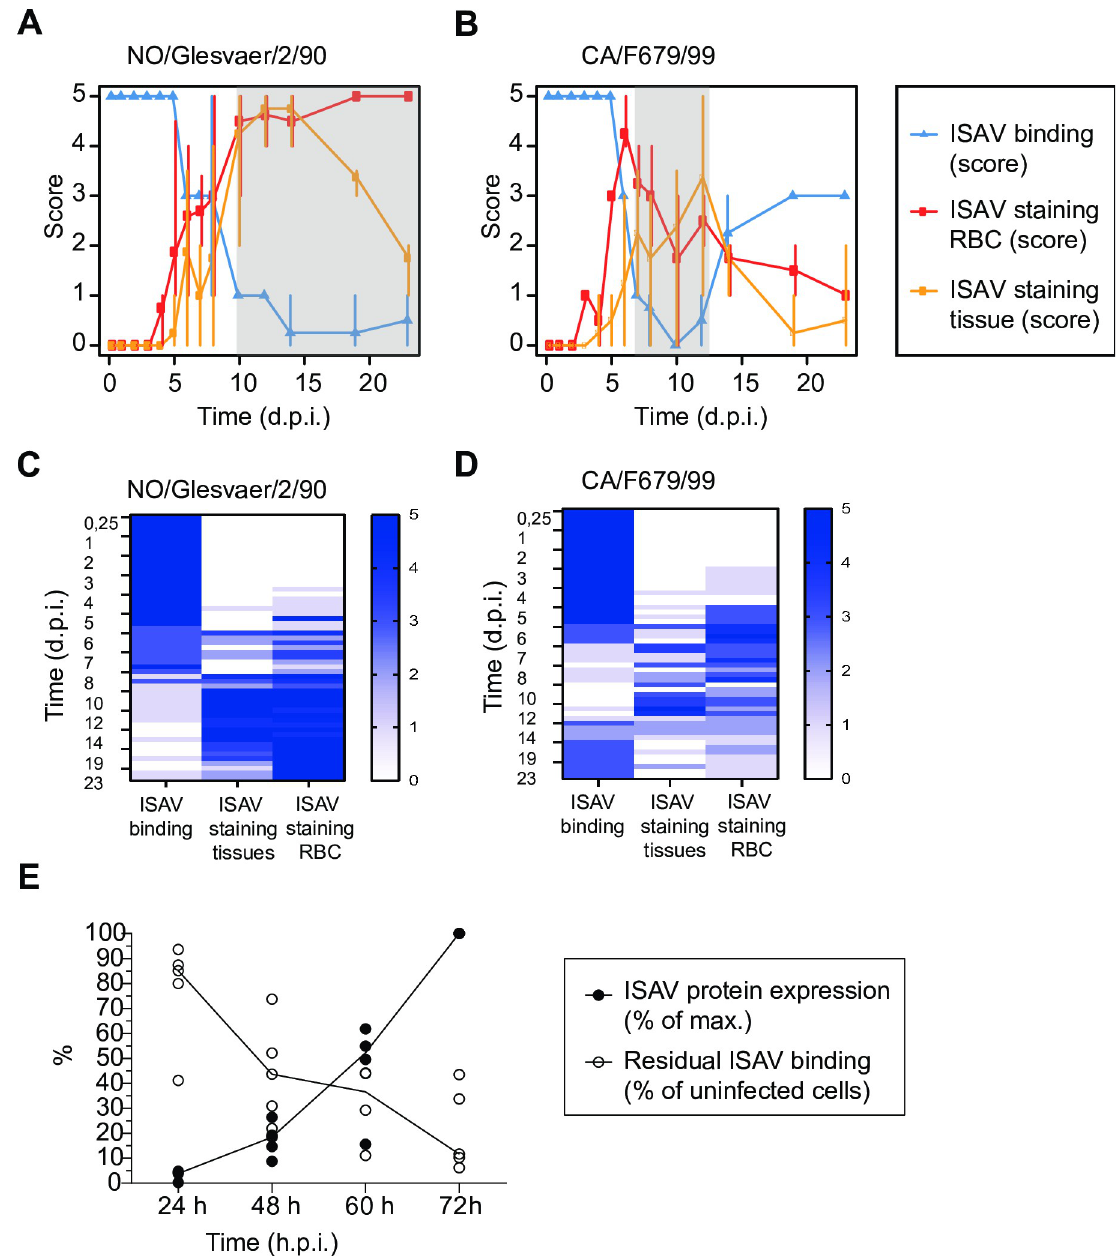
Fig 4. The loss of the cellular ISAV receptor correlates to circulating virus levels and cellular production of viral proteins. (A-D) Semi-quantitative scoring of virus histochemistry (ISAV binding, blue), immunohistochemical detection of ISAV NP in heart sections (ISAV staining tissue, yellow), and immunofluorescent staining of ISAV HE in blood smears (ISAV staining RBC, red) in fish infected with NO/Glesvaer/2/90 and CA/F679/99. Time points with individual fish VHC scores = / < 1 are indicated in grey. Graphs in (A-B) show mean and range of scores and heat maps in (C-D) show stacked scores in individual fish. (E) Cellular ISAV HE production measured by a cell-based ELISA (black dots) and inhibition of ISAV antigen binding to infected fixed cells by virus binding assay (open circles). Both assays used strain-specific antibodies to ISAV HE. Data points show normalised mean values of five experiments in three independent runs: Three experiments infected cells with CA/NBISA05/98 and measured NO/Glesvaer/2/90 binding. Two experiments infected cells with NO/Glesvaer/2/90 and measured CA/NBISA05/98 binding. Lines connect median values.